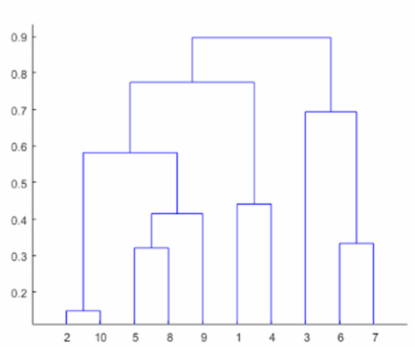
Figure 1. Example of dendrogram for hierarchical agglomerative